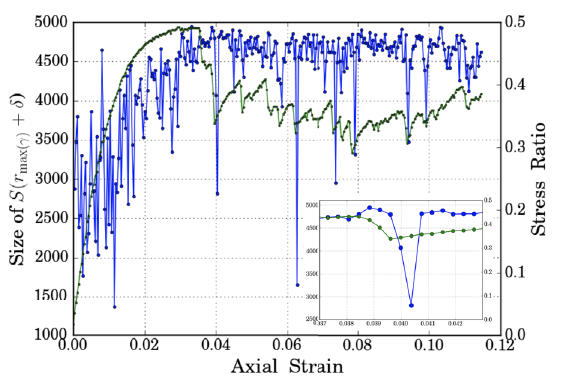
Figure 3. Evolution with strain of the size of S ( r max( γ ) ) and stress ratio. The significant drops in the critical state regime occur dur- ing jamming cycles: inset enlarges the rise in stress after ≈ 0 . 04 axial strain.